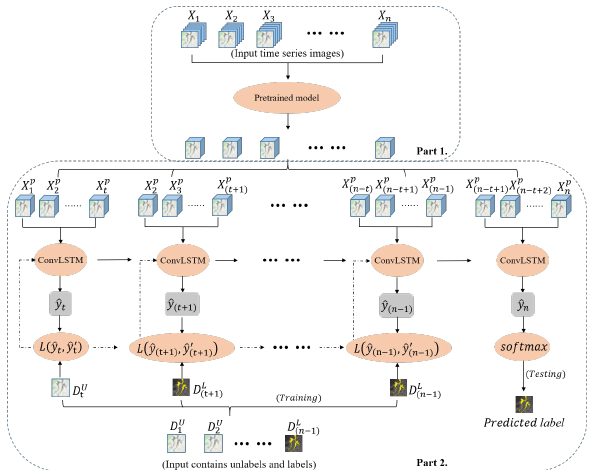
Figure 1. The framework overview of our proposed Semi- LSTM model for land cover classification in time series